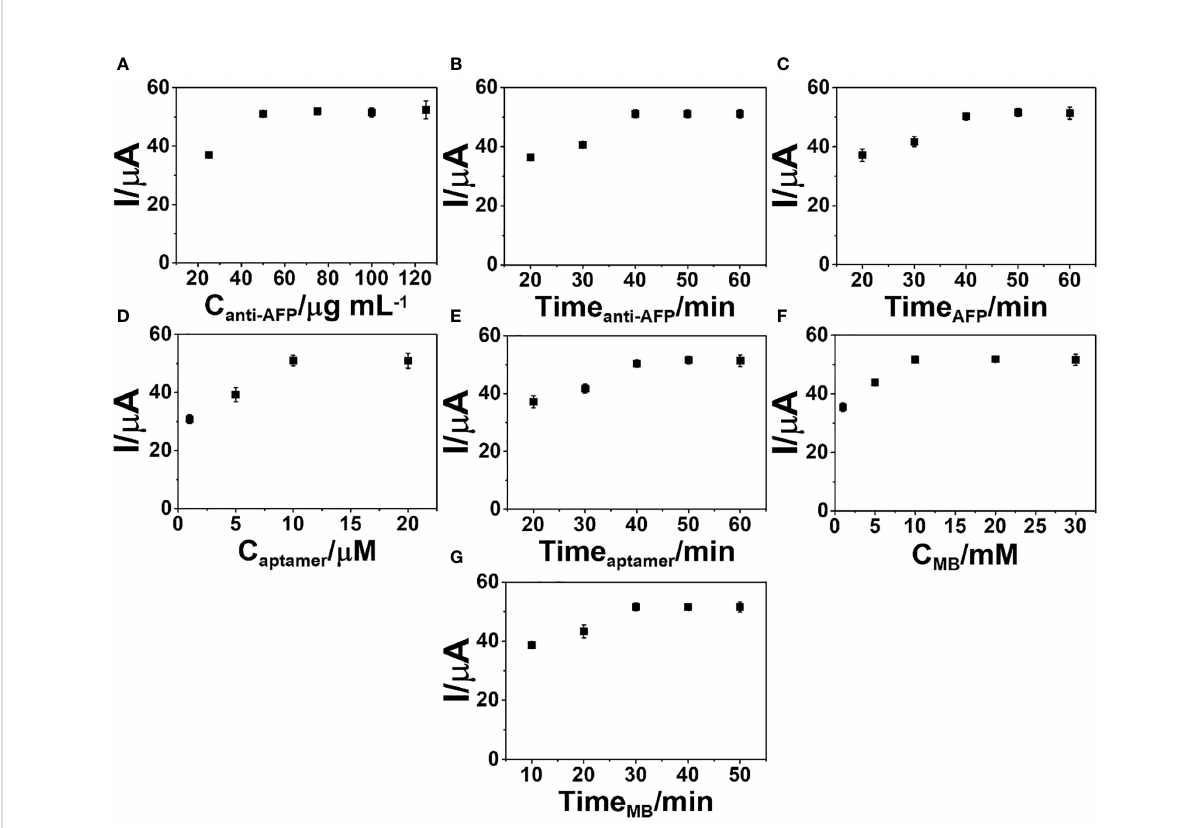
FIGURE 5 Optimization of the (A) anti-AFP concentration, (B) anti-AFP immobilization time, (C) incubation time for complete immunoreaction, (D) aptamer concentration, (E) incubation time of aptamer binding, (F) MB concentration for the signal generation, and (G) incubation time of MB intercalation into the sensing surface for the construction of the developed sandwich-like